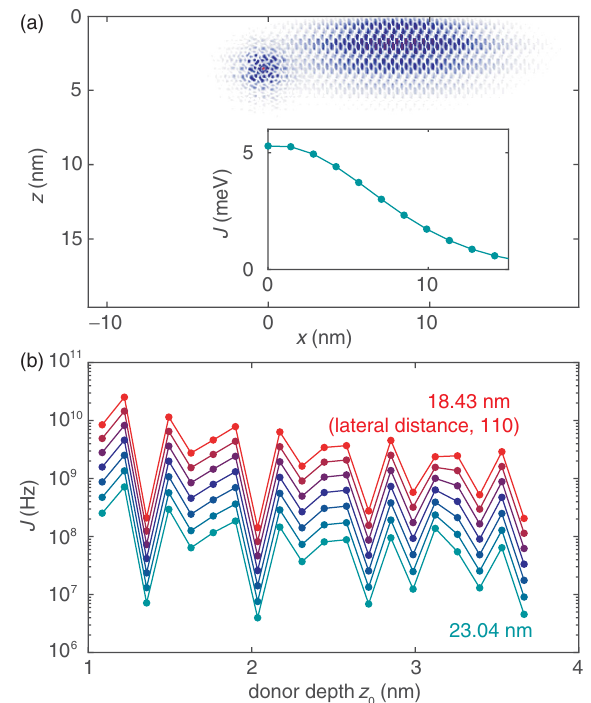
FIG. 4. (a) Calculated electron density for donor and quantum dot, where only the donor contains lattice incommensurate components. Inset: Predicted decay of exchange as a function of donor-QD distance. (b) Calculated dependence of donor-QD exchange on donor depth, for different displacements along 110 between 18.43 and 23.04